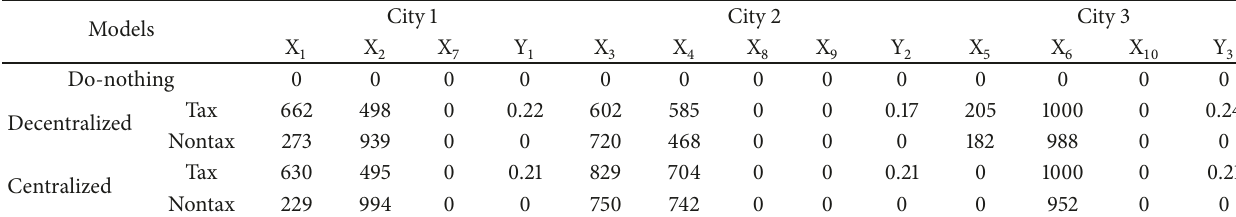
Table 2: Optimal solutions for three logistics network design models.